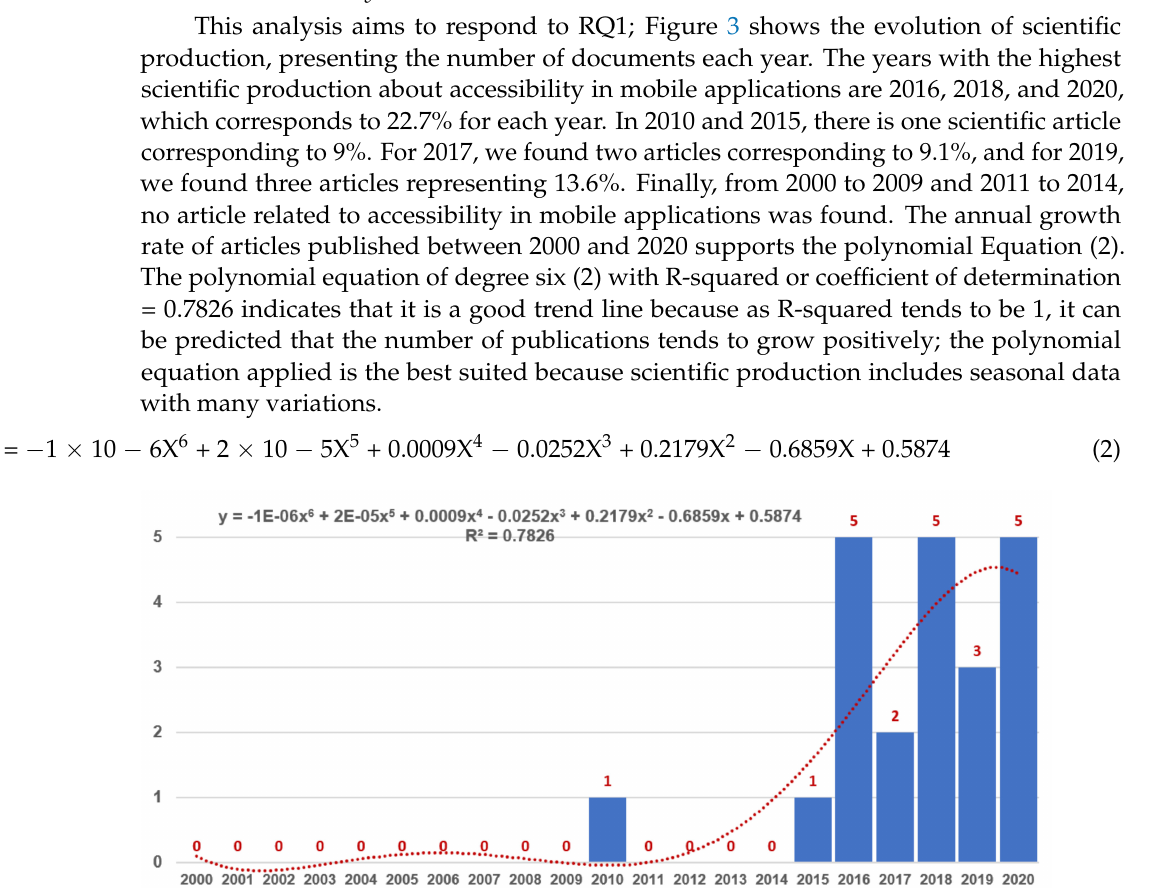
Figure 3. Articles published from 2000 to